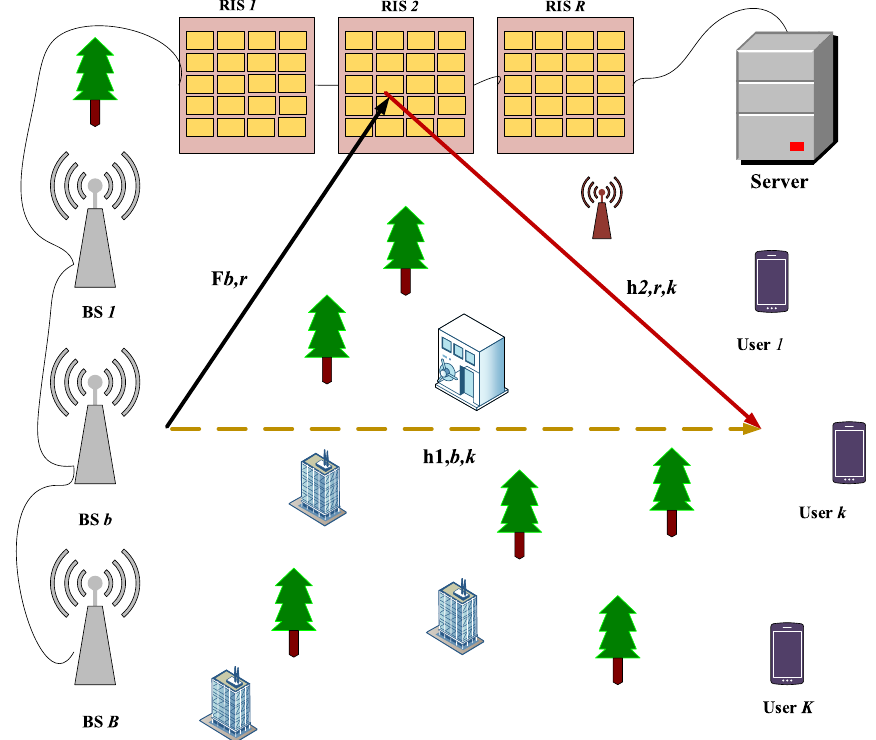
Figure 1. A RIS-aided cooperative CF